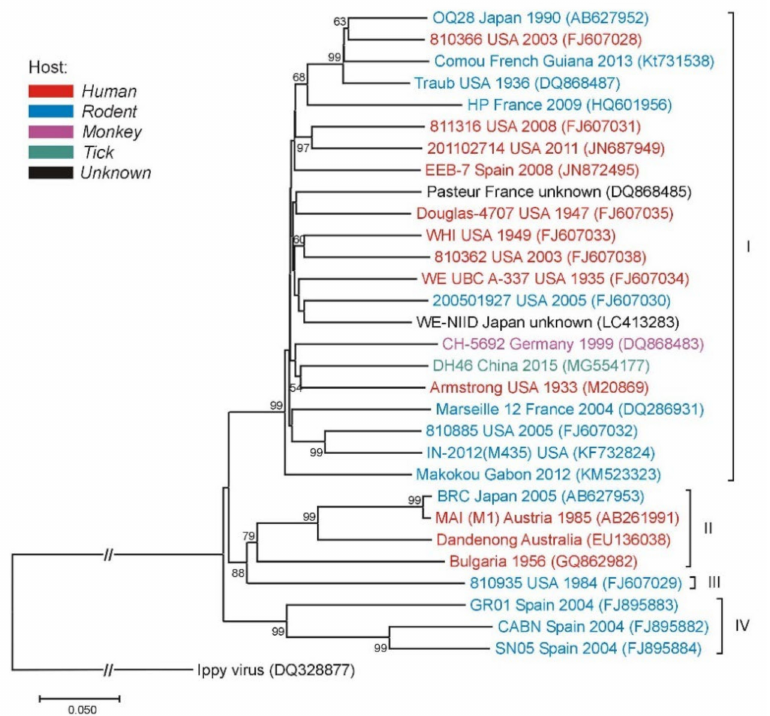
Figure 3. Phylogenetic neighbor-joining analysis of the lymphocytic choriomeningitis virus (LCMV) based on the small (S) gene segment. The tree is rooted with the Ippy virus. Strain/isolate designa- tions, countries of origins, isolation/detection years and GenBank accession numbers are indicated at the branches. LCMV genetic lineages are indicated on the right. Supporting ( ≥ 50%) bootstrap values of 1000 replicates are displayed at the nodes. Horizontal distances are proportional to genetic distance. Scale bar indicates nucleotide substitutions per site. The interrupted branches, indicated by double slashes, were shortened by 50% for better graphic